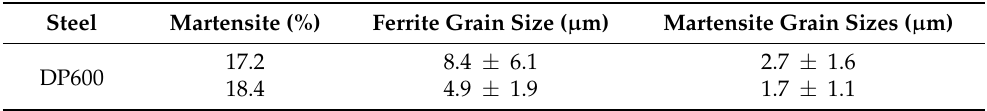
Table 1. The chemical composition and microstructural characteristics of DP 600 used in the current study. Reprinted with permission from Ref. [10] Copyright 2014 Elsevie.